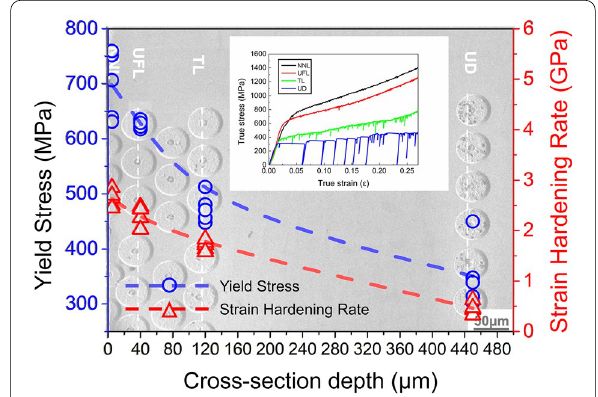
Figure 8 Yield stress and SHR of micropillars along cross-section depth. Inserted image shows representative strain-stress